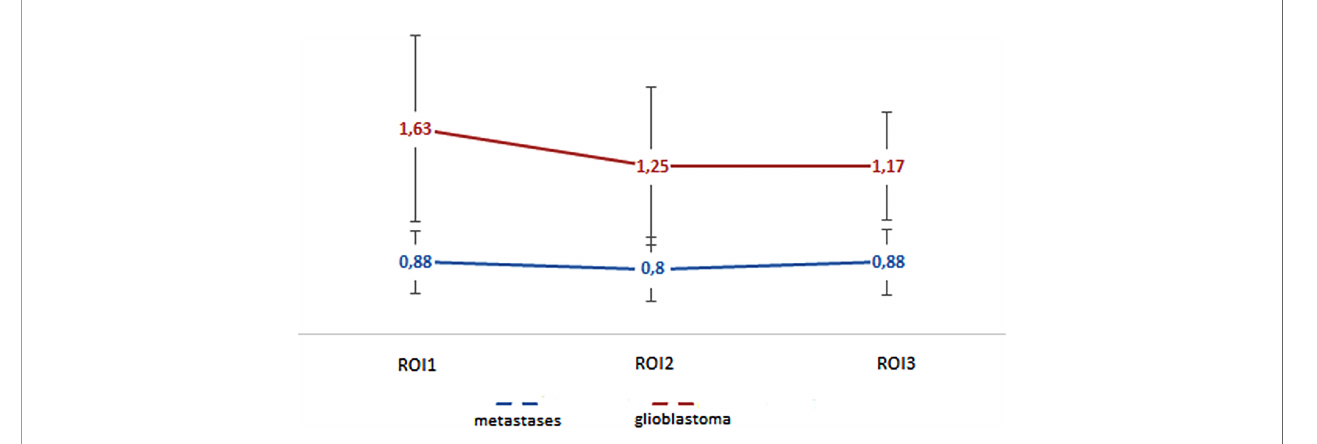
FIGURE 6 | Changes in blood fl ow indicators in areas of interest: edema (metastases) and edema with in fi ltrative component